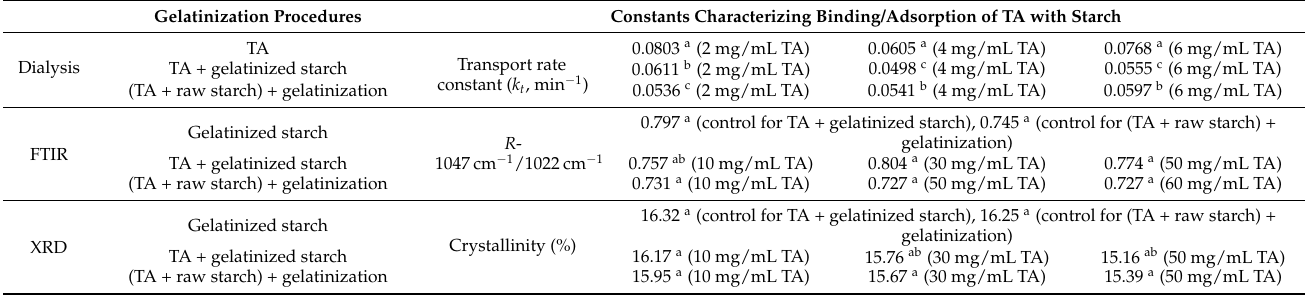
Table 2. The methods and corresponding constants that characterize the binding/adsorption of TA with starch for two gelatinization